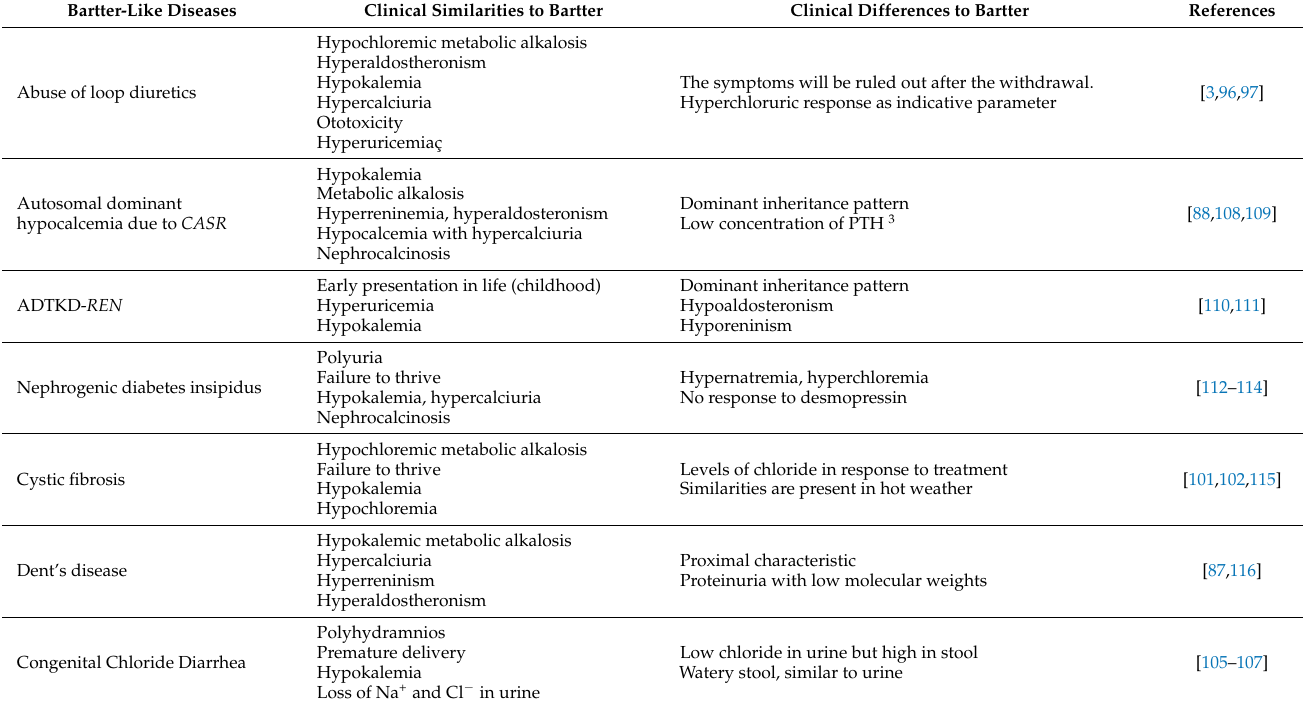
Table 3. Clinical entities that mimic Bartter